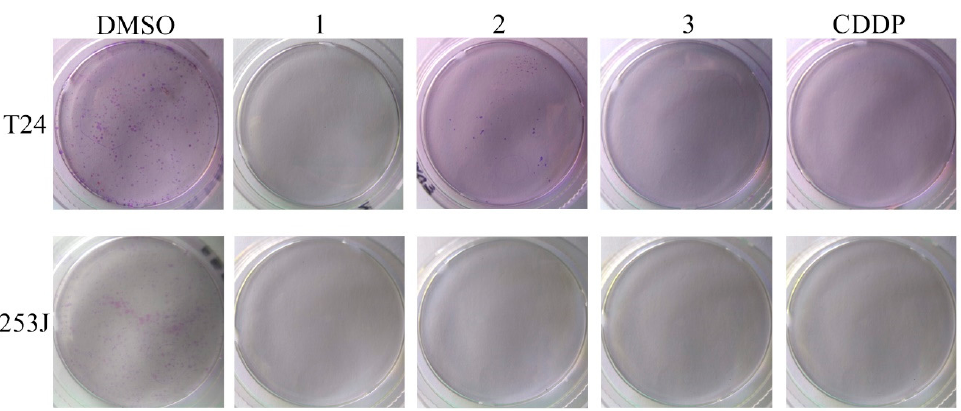
Figure 5. Clonogenic assay performed in T24 and 253J cells. Cultures were exposed to compounds 1 , 2, and 3 or cisplatin (CDDP) at 10 µM. Table 2. Clonogenic assay of T24 and 253J cells treated with compounds at 10 µM. Cell Line